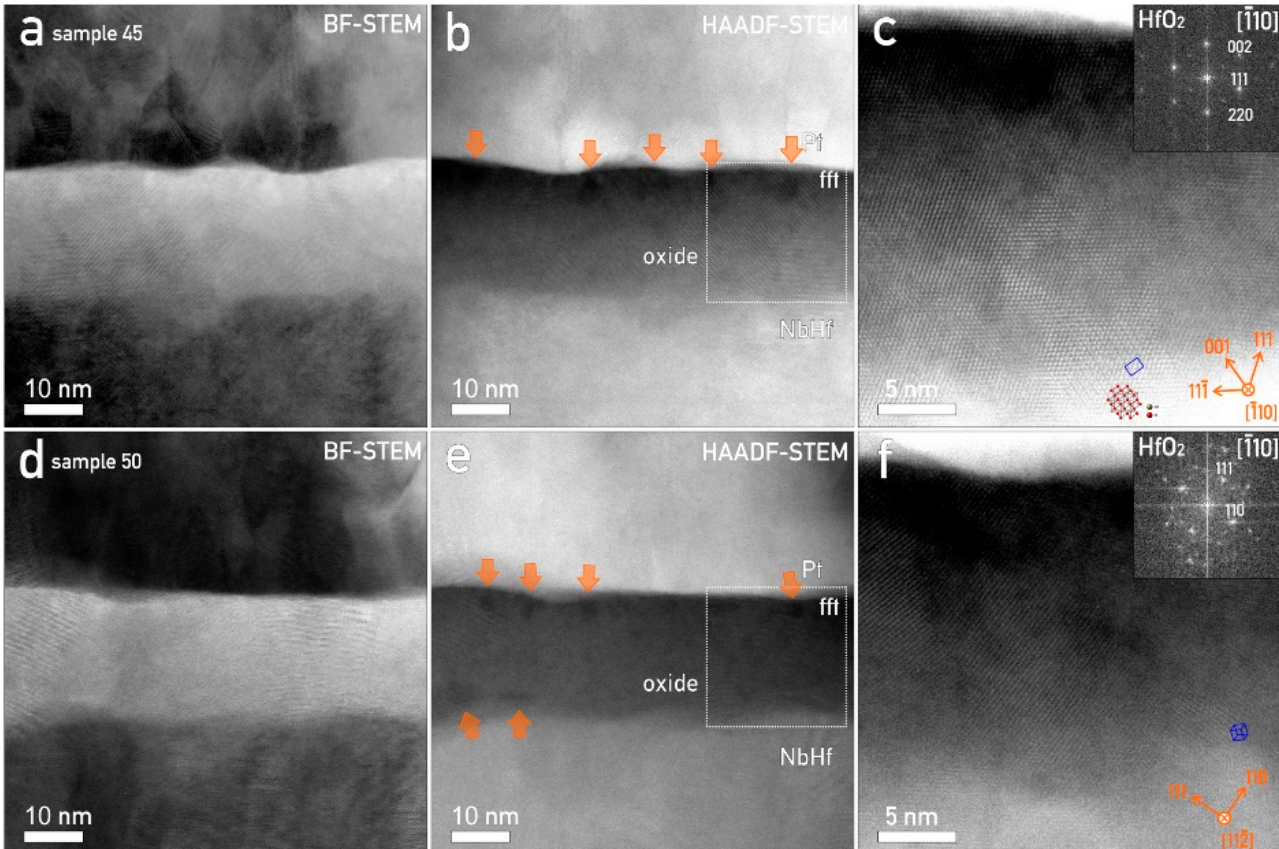
Figure 6. Nanostructural characterization of the Hf–Nb oxide layer, top: sample Hf-45 at.% Nb and, bottom: sample Hf-50 at.% Nb. ( a , d ) BF-STEM and ( b , e ) HAADF-STEM micrographs of crystalline and amorphous oxide layer; orange arrows mark amorphous regions. ( c ) Sample Hf-45 at.% Nb: large HfO 2 crystallites extending through whole width of the oxide layer. ( f ) Sample Hf-5 at.% Nb: smaller HfO 2 randomly oriented crystallites.